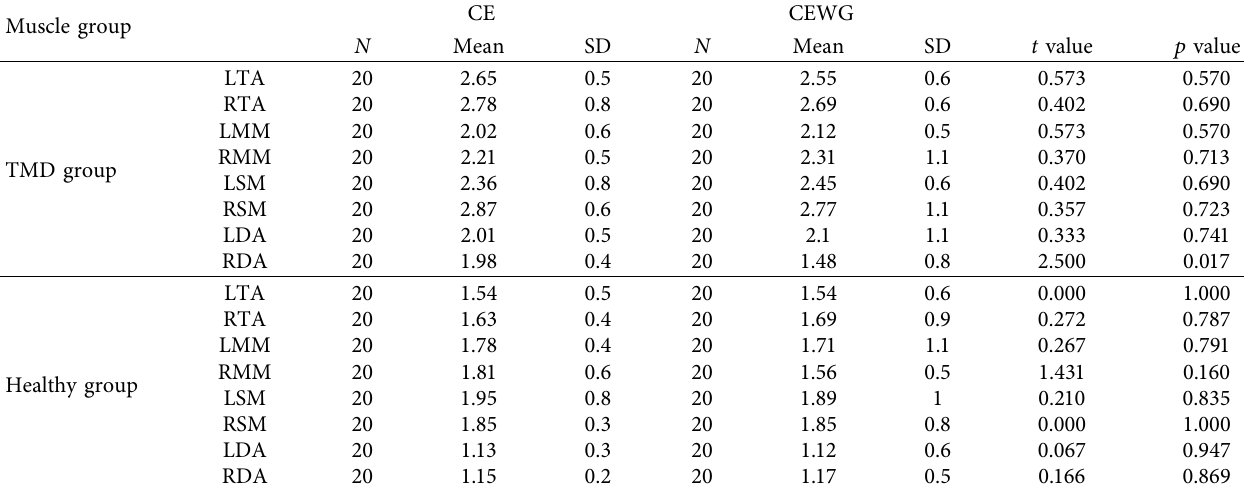
Table 4: EMG values with eyes closed and with glasses on.